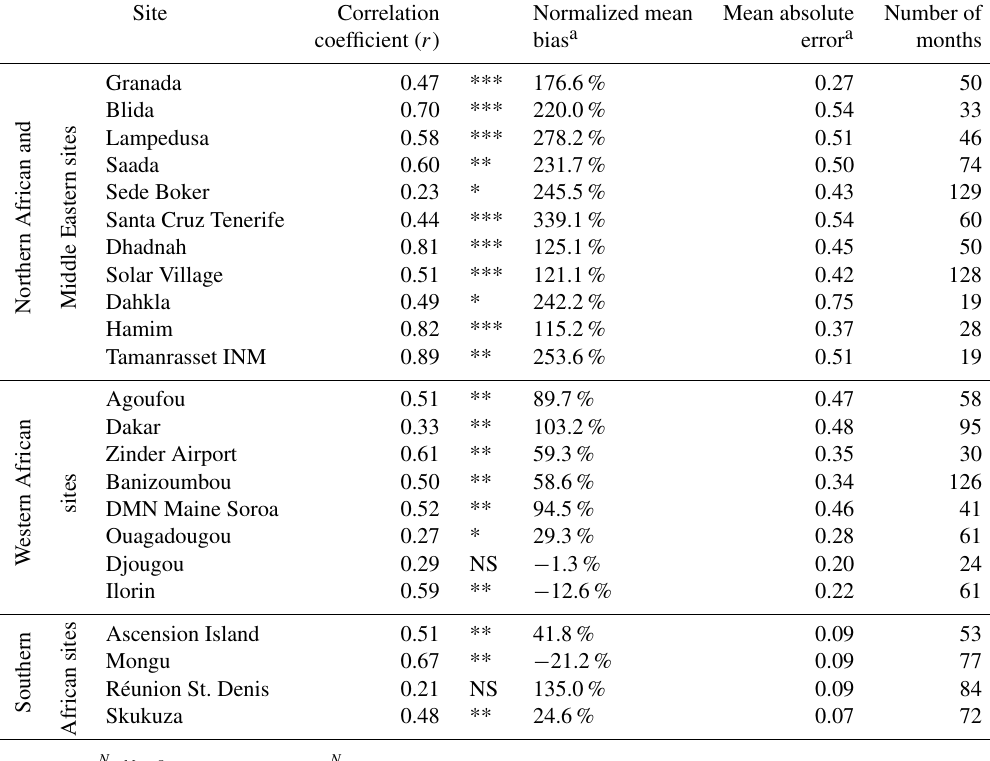
Table 4. Summary of model–observation comparison of monthly-average AOD 550nm . The significance of the Pearson’s correlation is indi- cated by “*” for p < 0 . 05, “**” for p < 0 . 01, and “***” for p < 0 . 001; NS is not significant at 0.05